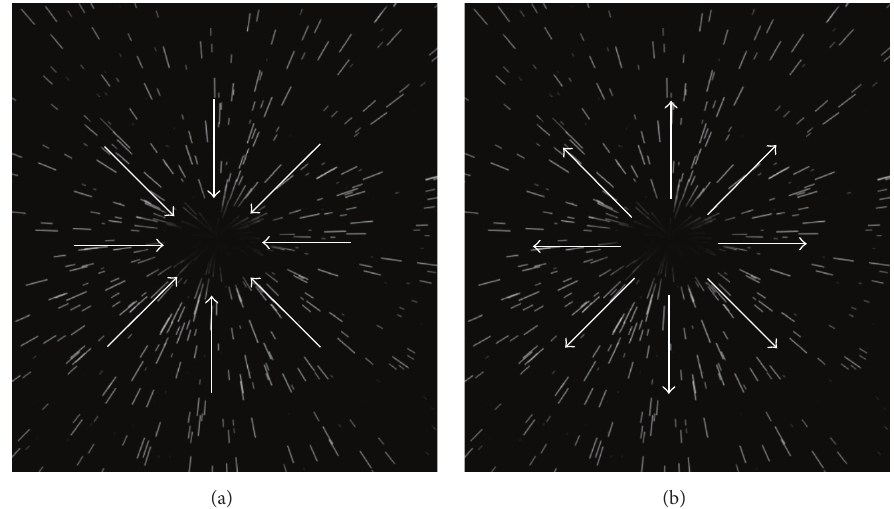
Figure 1: Illustrations of the direction of centripetal (a) and centrifugal (b) optic flow stimuli in trials with backwards and forwards motion direction,